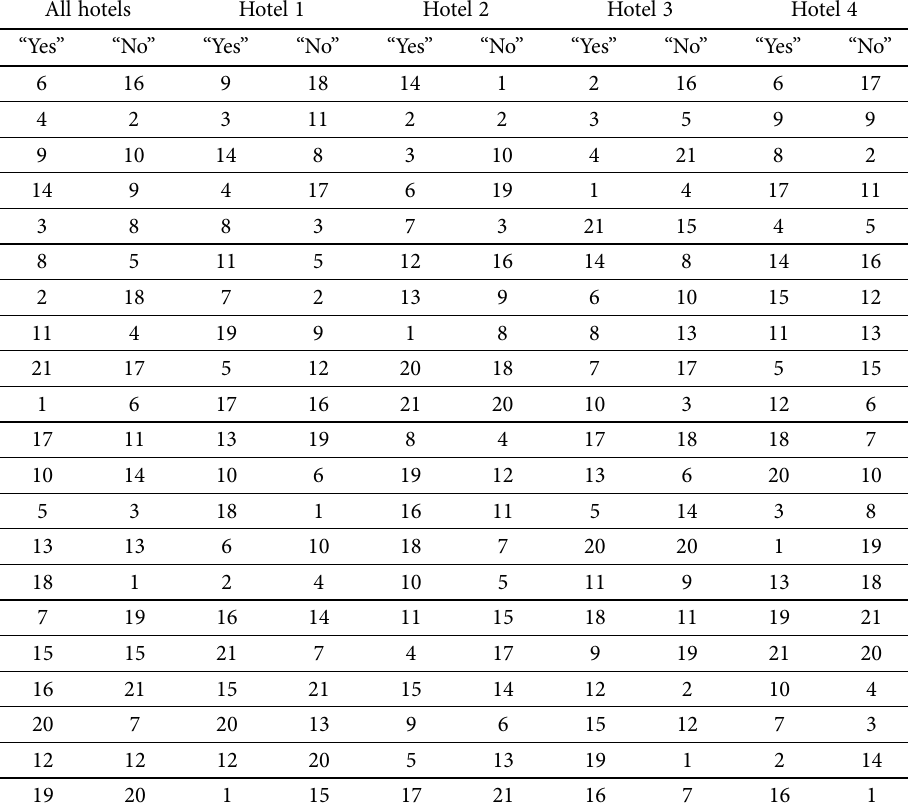
Table 16. Decreasing ordering of the importance of attributes related with the experience All